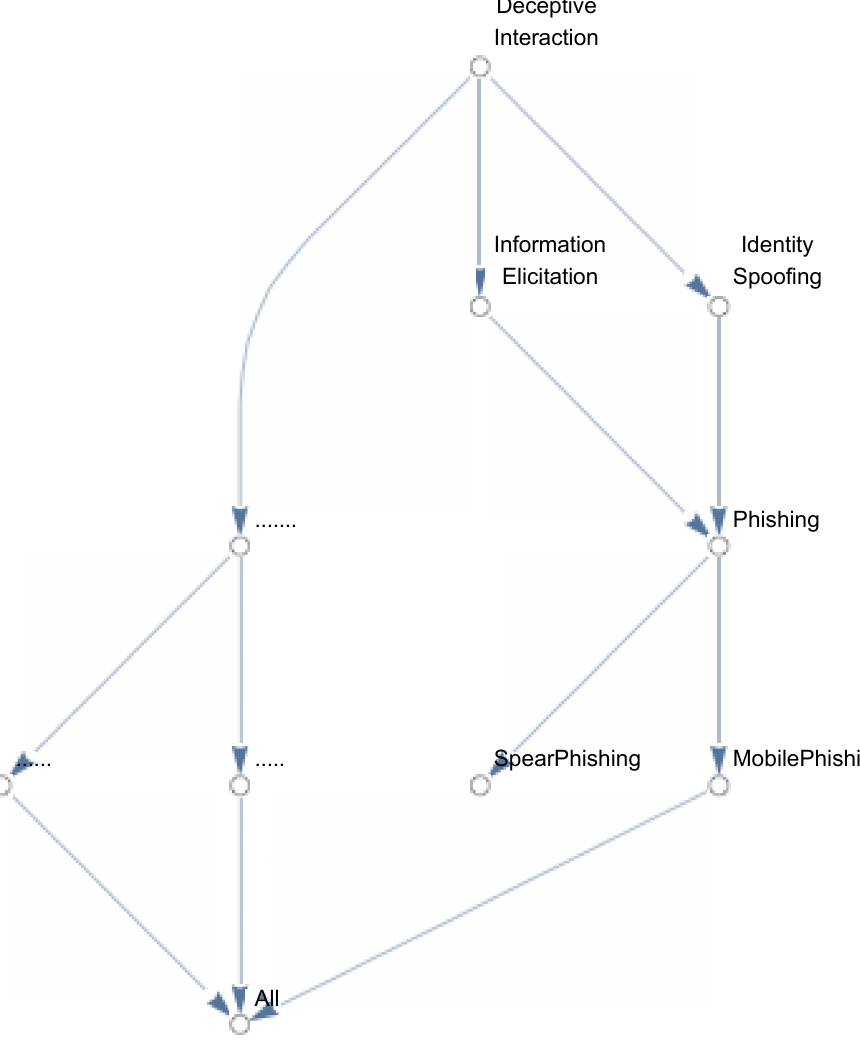
Figure 1. Fragment of a formal concept lattice for analysis of cyberattacks, taken from the ATT&CK datatset. The lattice is based on links between tactics, which are extracted from the dataset.